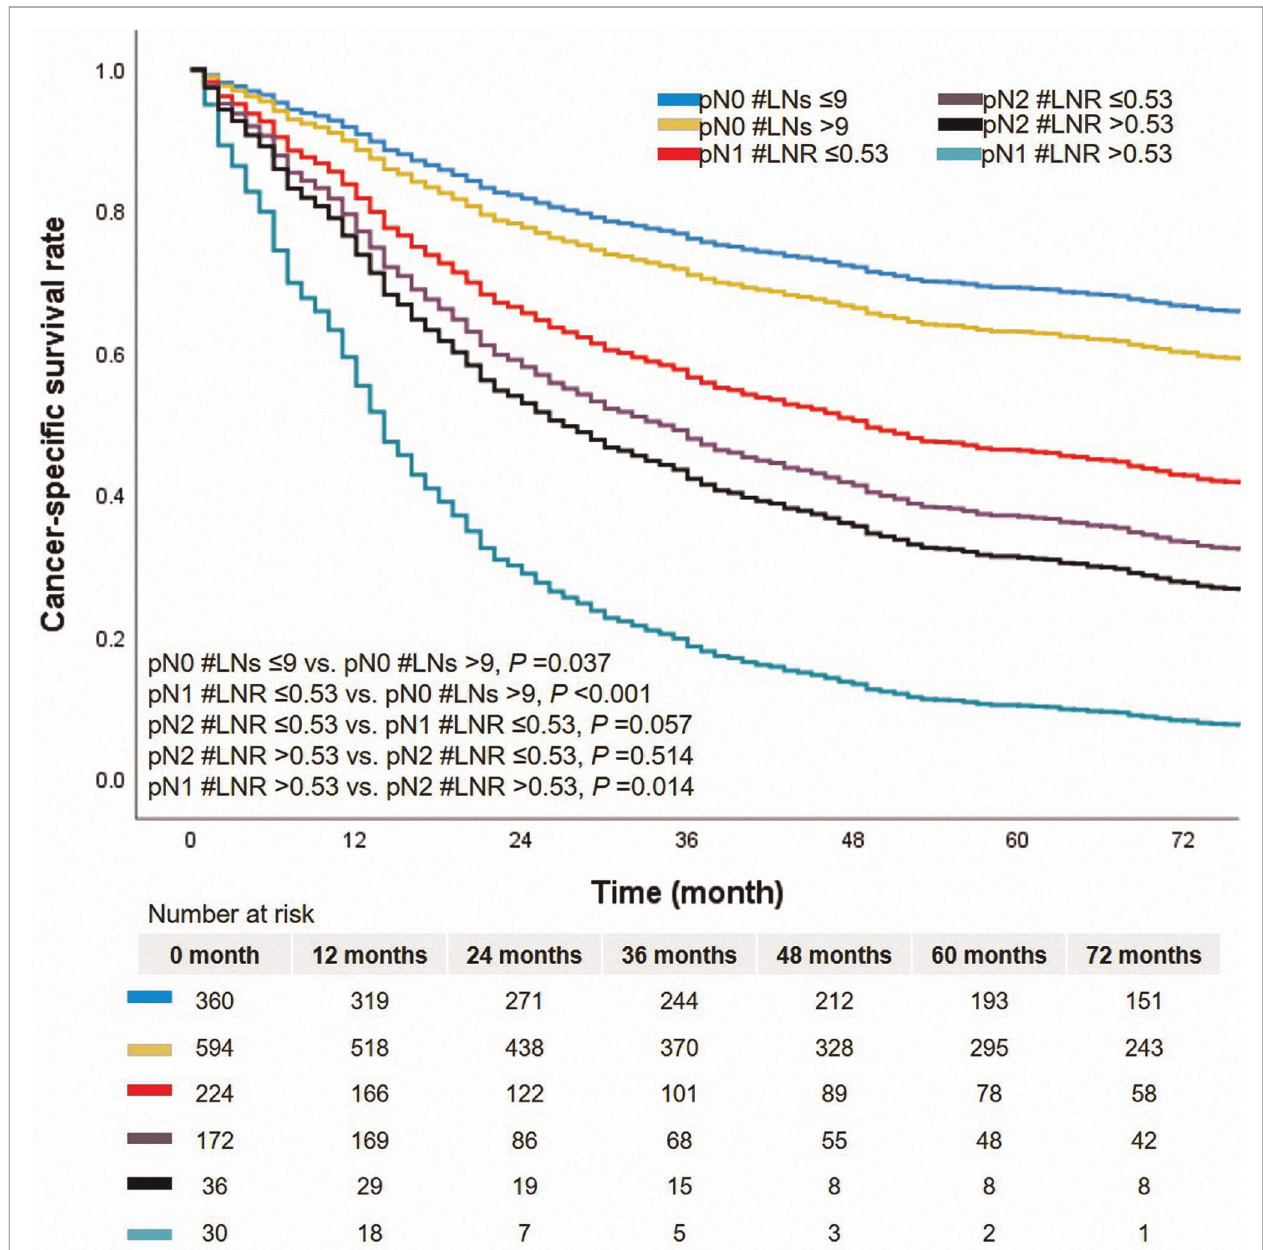
FIGURE 5 | The survival curves of sub-group analysis based on LN indicator. LN, lymph